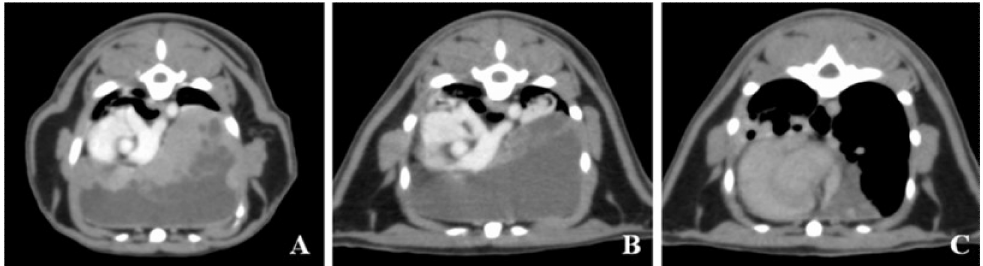
Figure 2. Transverse images of contrast computed tomography (CT) ( A ) preradiation therapy (RT), ( B ) post-RT, and ( C ) post-aspiration at eighth thoracic vertebra level. The pre-RT CT images obtained for treatment planning reveal fluid retention in the tumor, though the fluid is aspirated at initial diagnosis. The volume of tumor is not decreased in post-RT. The tumor structure is changed to cystic post-RT, and the tumor volume is decreased by approximately 80% after aspiration than that before